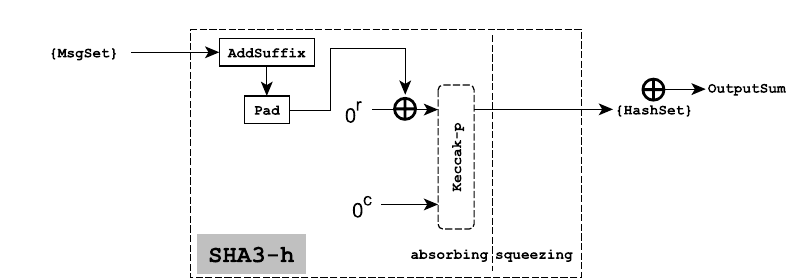
Figure 1: A generic view of the proposed experiment